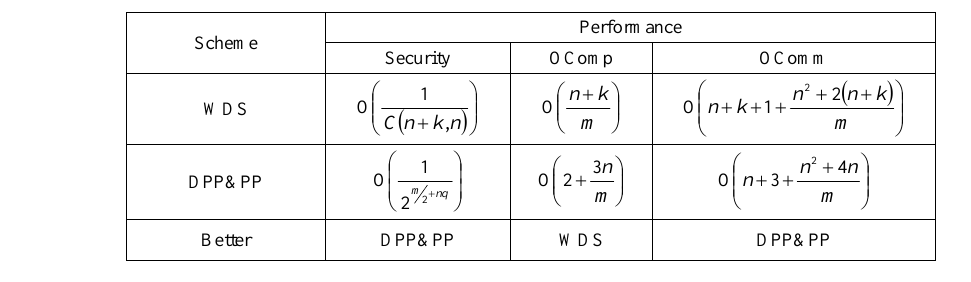
Table 1. Comparison between WDS and